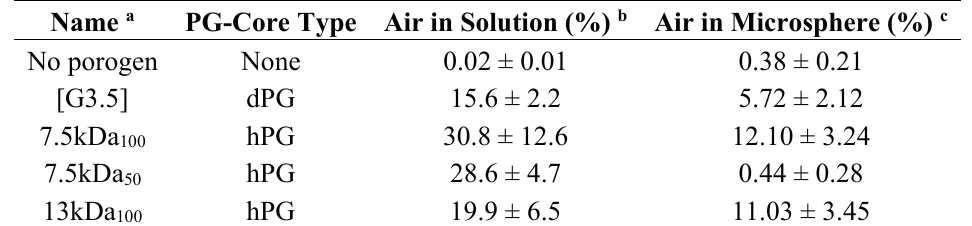
Table 2. Overview of the porogens seen in Table 1 and their air-in-solution values compared to the resulting microsphere